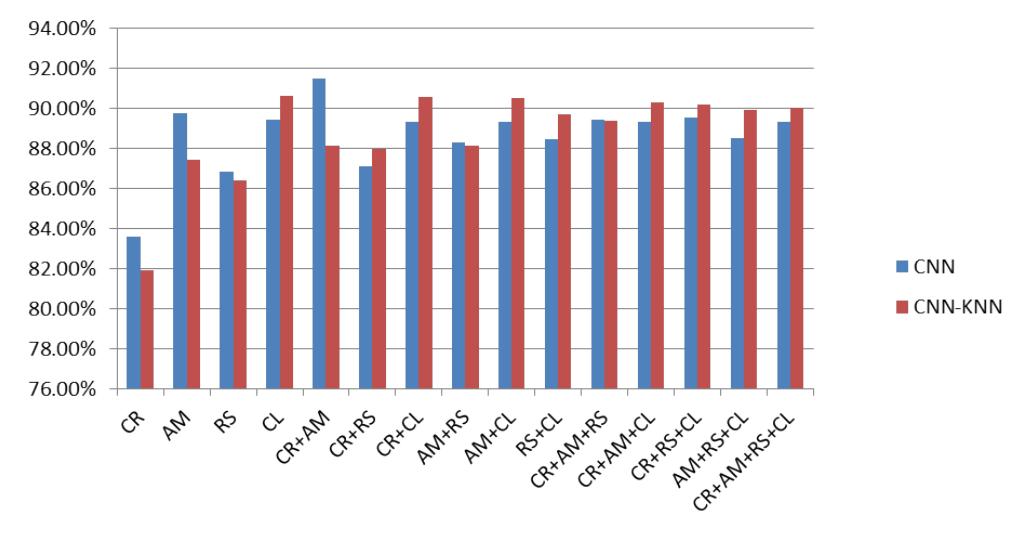
Figure 7. Fusion of CNN-KNN as substitute of CNN softmax layer.